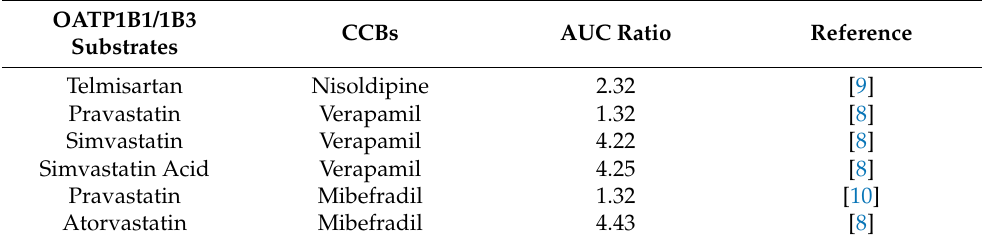
Table 3. In vivo DDI of CCBs against OATP1B1/3 drug